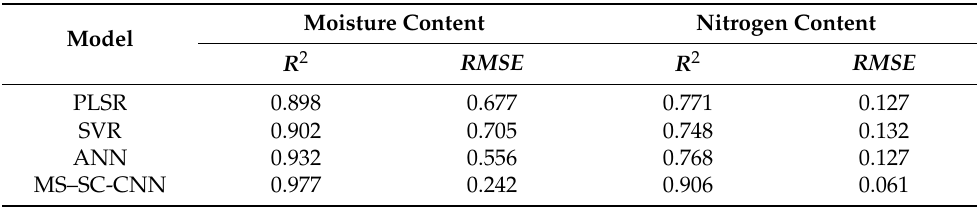
Table 4. Results of the moisture and nitrogen content in Pinus massoniana leaves using different regression